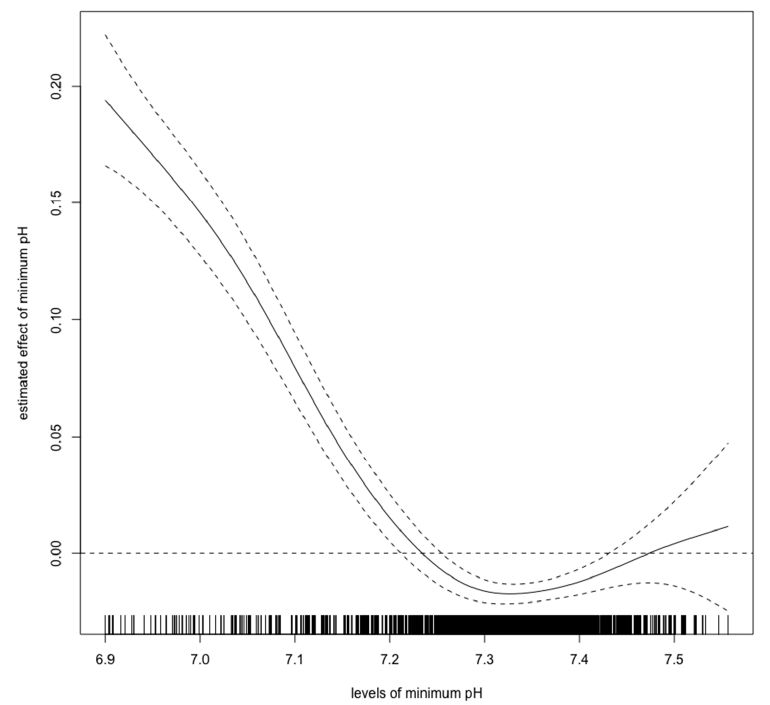
Figure 3. Nonlinear relationship between the pH and 28-day mortality in critically ill children with acute kidney injury. The curve: estimated spline function in log odds ratio on the effect of the pH. The dotted lines: 95% confidence interval.